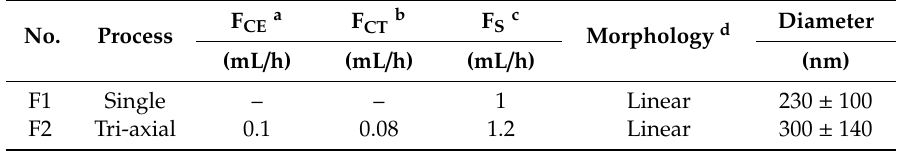
Table 1. Key parameters for the electrospinning processes and their